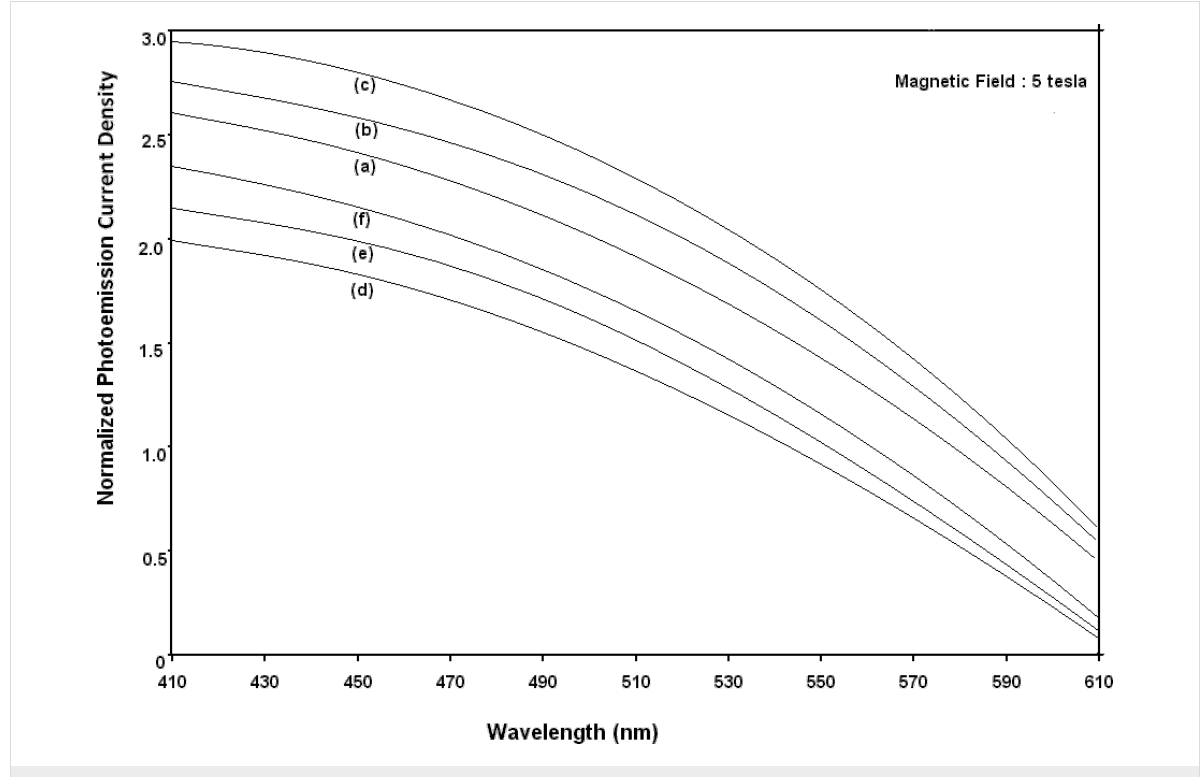
Figure 19: Plot of the normalized magneto photoemission current density from effective mass superlattices of HgTe/Hg 1 − x Cd x Te and In x Ga 1 − x As/InP as a function of wavelength for all cases of Figure 16.